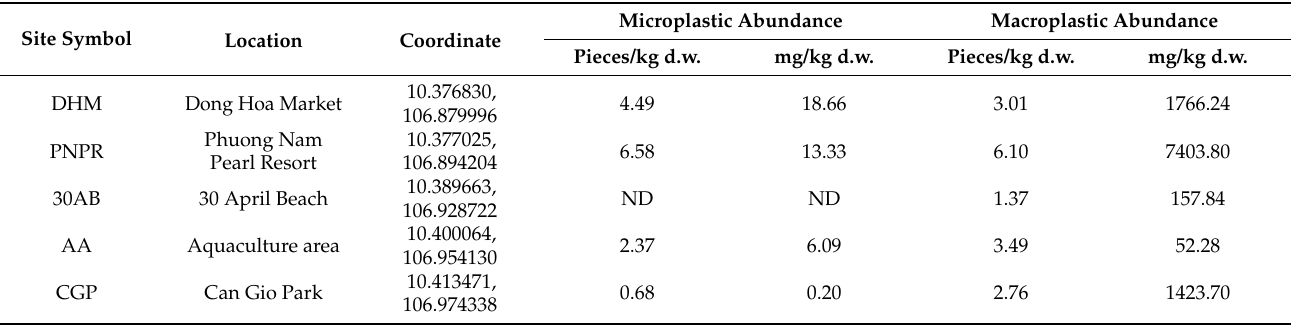
Table 1. Abundance of microplastics and macroplastics in beach sand samples in Can Gio, Ho Chi Minh City, Vietnam in November